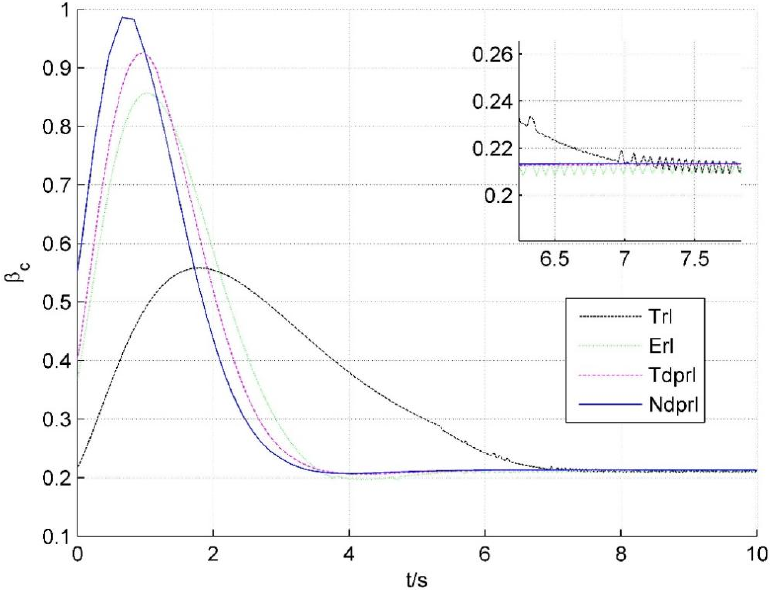
Figure 3. Controller output, β c , under reaching laws.